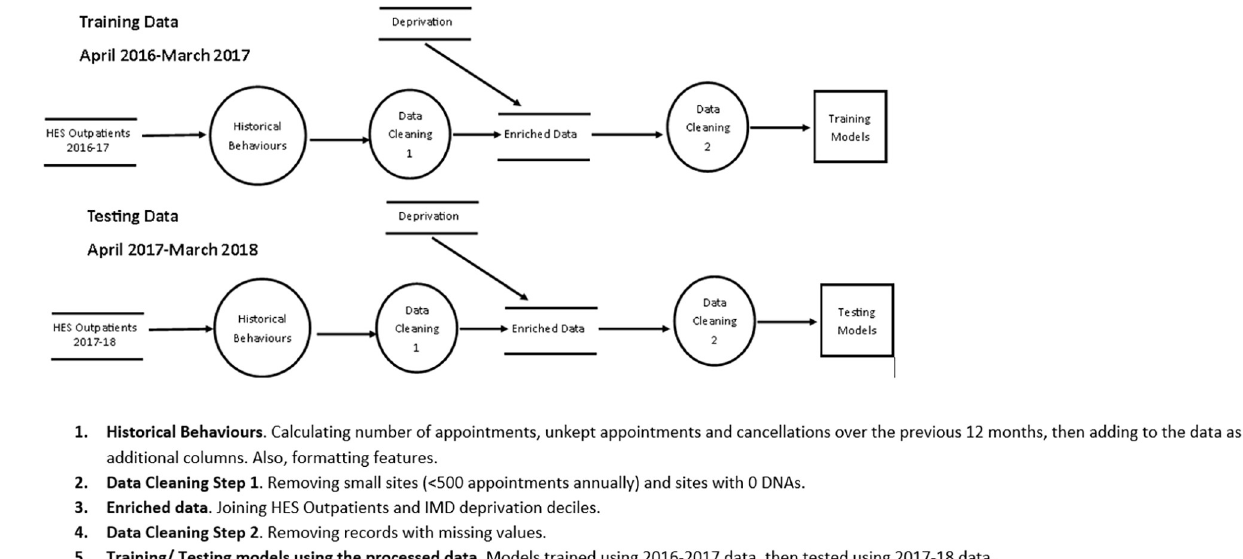
Fig 1. Data flow diagram. Numbers of appointments and unkept appointments were obtained for the top 50 trusts by appointment volume. Unkept appointments within Imperial College Healthcare NHS Trust were further broken down by specialty. DNA, did not attend; HES, Hospital Episode Statistics; IMD, Index of Multiple